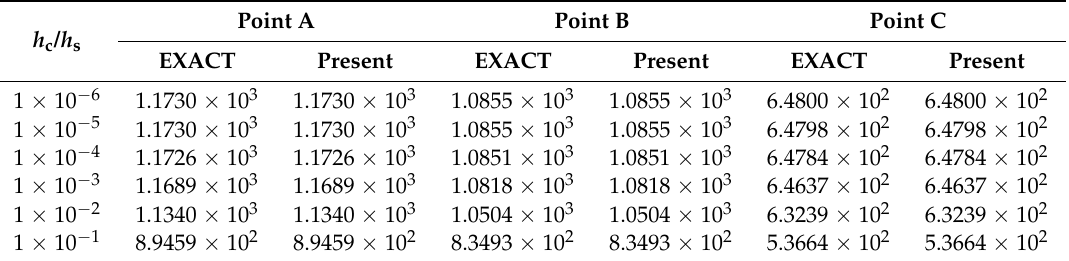
Figure 5. Configuration of the coating/substrate system in the first test. Table 1. Temperature results at the three specific points for different thickness ratios in the first test.